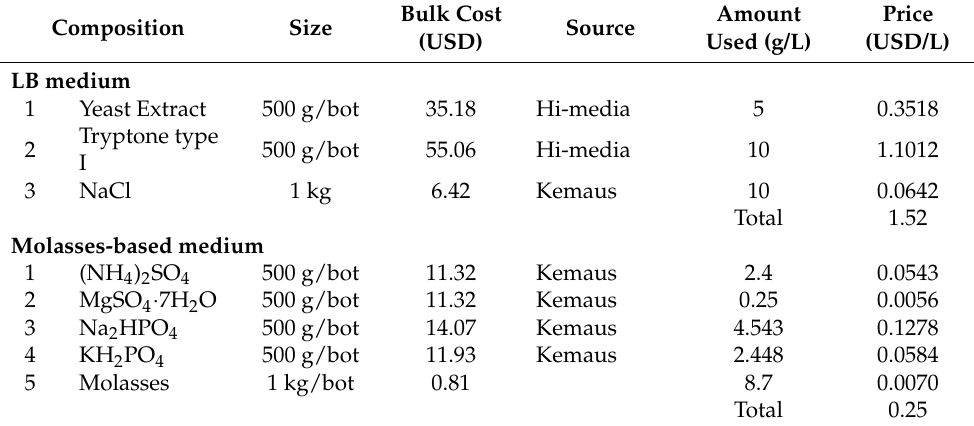
Table 3. Comparative cost estimation of materials for molasses-based medium and LB